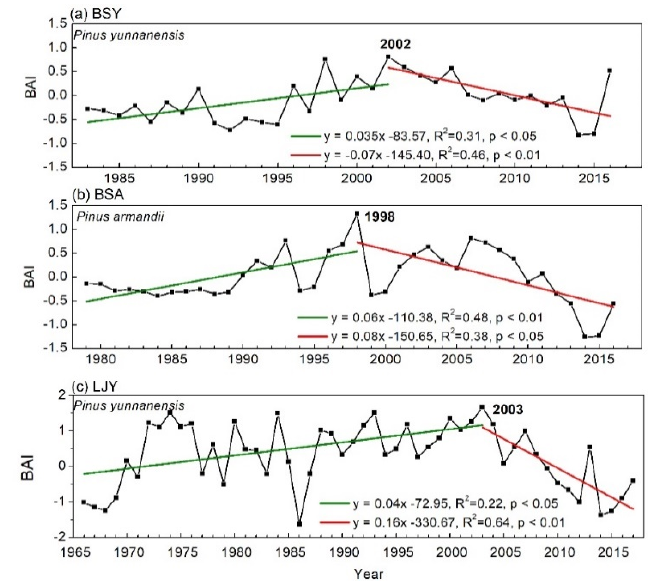
Figure 4. Change trends in the normalized basal area increments (BAI) of Pinus yunnanensis (102 cores) at BSY ( a ) and LJY ( c ) and Pinus armandii (103 cores) at BSA ( b ) in Baoshan and Lijiang, Yunnan, southwest China. BSY = (Baoshan yunnanensis) site where P. yunnanensis samples were collected in Baoshan. BYA = (Baoshan armandii) site where P. armandii samples were collected in Baoshan. LJY = (Lijang yunnanensis) site where P. yunnanensis samples were collected in Lijiang.